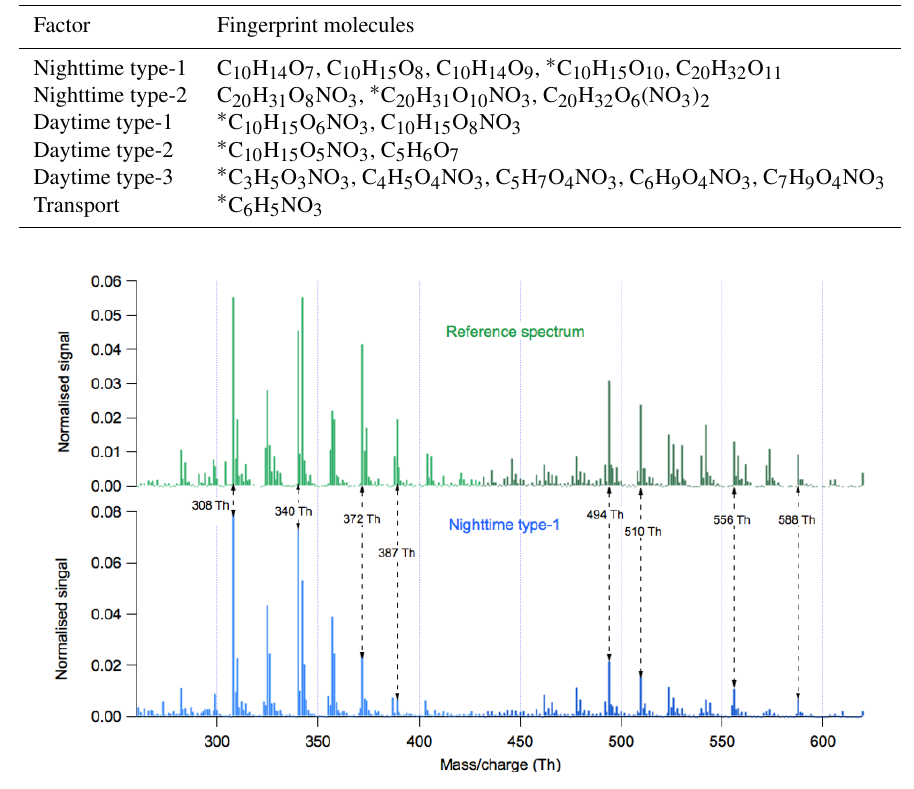
Figure 8. Comparison between the reference spectrum (Ehn et al., 2014) and the O 3 + monoterpene